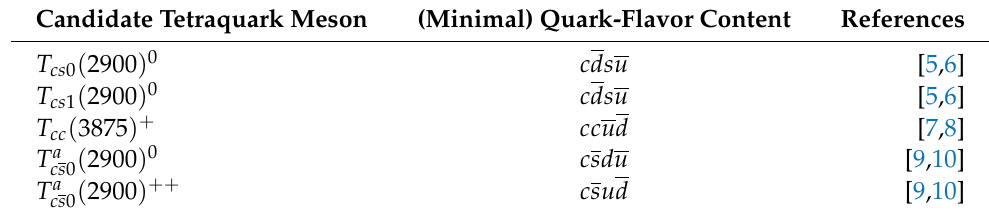
Table 2. Flavor-exotic tetraquark states: Experimental candidates, in the naming convention of LHCb [4]. Candidate Tetraquark